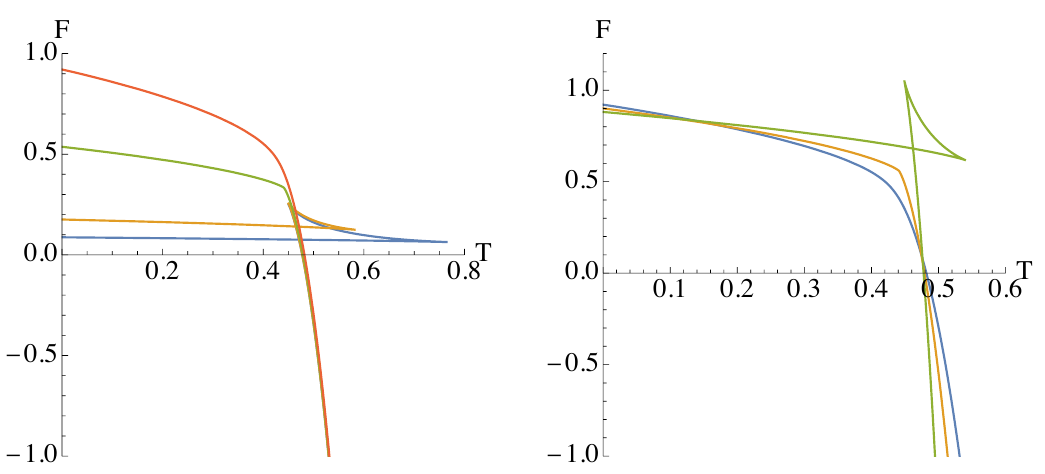
˜ Figure 1 . Free energy F vs. temperature T plot in d = 4 for the fixed ( Q, V , C ) ensemble. Left : we plot different values of ˜ Q for fixed R and C , the parameters are R = 1 , C = 1 and ˜ Q = √ 0 . 1 , 0 . 2 , 4 / 3 5 , 1 (blue, orange, green, red). For Q < Q (blue, orange) the free energy displays crit “swallowtail” behaviour and a first-order phase transition occurs between two thermodynamically stable branches. The “horizontal” branch has low entropy, while the “vertical” branch has high entropy. The intermediate branch that connects these two branches has negative heat capacity and is hence unstable. For Q = Q (green) there is a second-order phase transition, and for crit ˜ Q > Q crit (red) there are no phase transitions. Right : We plot different values of C for fixed Q and √ ˜ 5 / 4 , 4 (blue, orange, green). As in the charged R , the parameters are R = 1 , Q = 1 and C = 1 , 3 case, the plot exhibits different behaviours below and above the critical value, this time, a critical central charge. The swallowtail and first-order phase transitions occur for C > C (green). This crit transition becomes of second order at C = C (orange) and for C < C only a single phase crit crit exists, as implied by the smooth single-valued curve (blue). The two apparent triple intersections of the blue, orange and green curves is a consequence of plotting resolution; there are no triple